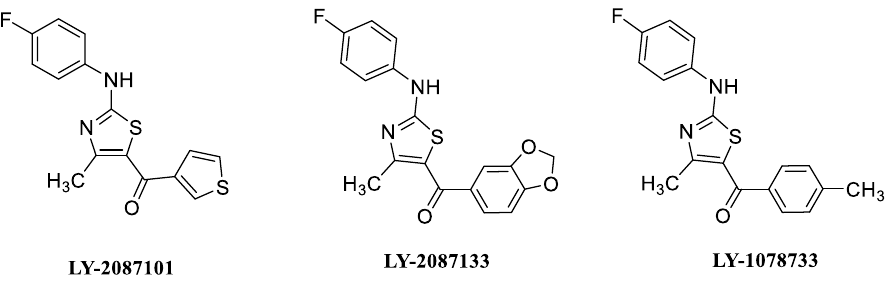
Figure 6. Examples of non-selective α AChR PAMs.